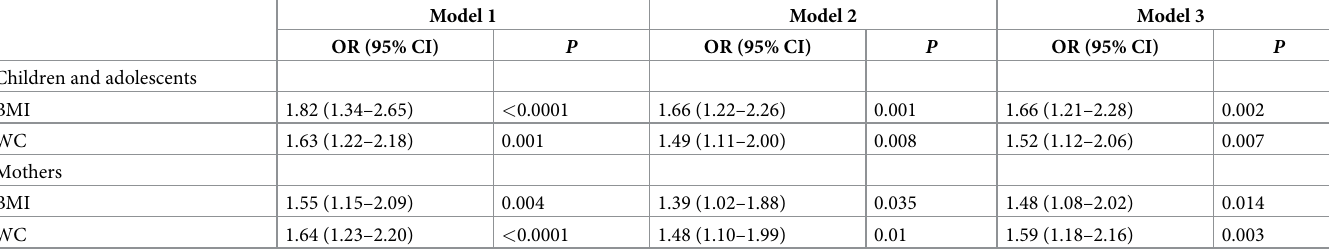
Table 2. Association between dietary knowledge and overweight and obesity in children and adolescents.